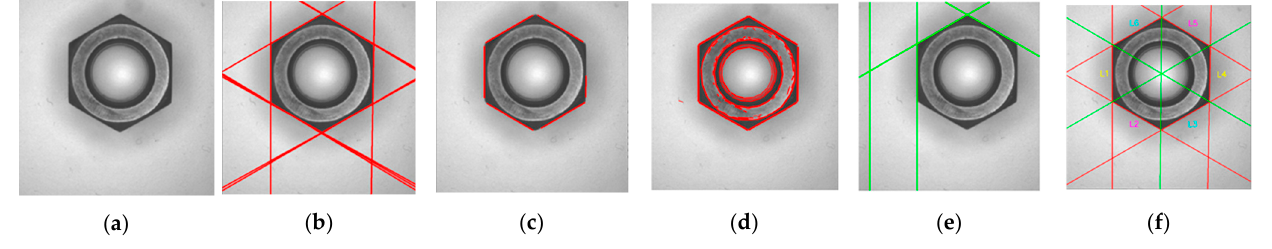
Figure 15. Comparison of other methods, the colored lines are the edges found by this method:( a ) original; ( b ) standard Hough line; ( c ) Hough line probabilistic; ( d ) line segment detect; ( e ) Hough line use threshold; ( f ) ours.